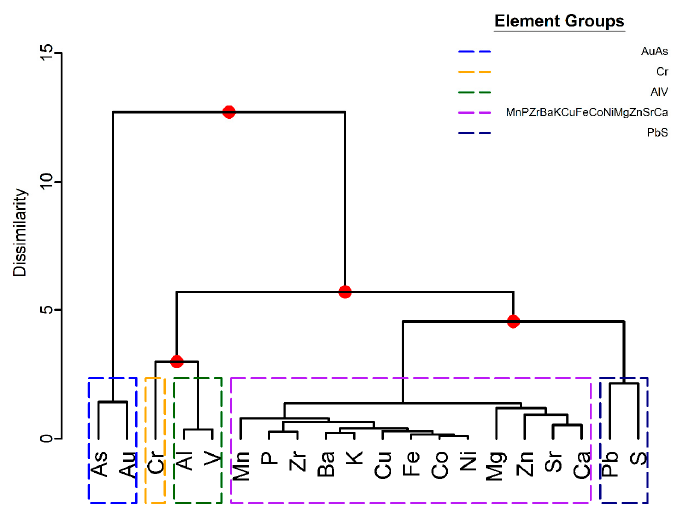
Figure 14. Dendrogram of hierarchical clustering results on the variation matrix of fresh rock observations. Red points indicate the cluster splits. Codependence among variables decreases from the bottom to the top of the diagram. The top of the colored boxes corresponds to the dissimilarity at which clusters of elements are taken to create composite variables. The variation matrix is available Table A2.